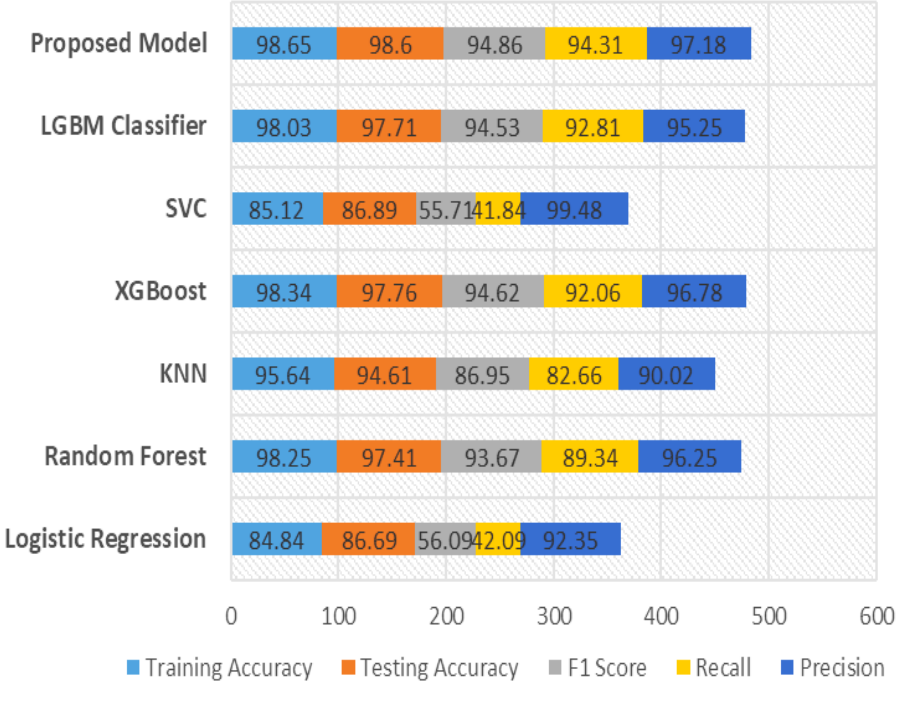
Figure 7. Comparison of scores for the proposed model. Table 2. Comparison of performance of the proposed algorithm with popular published